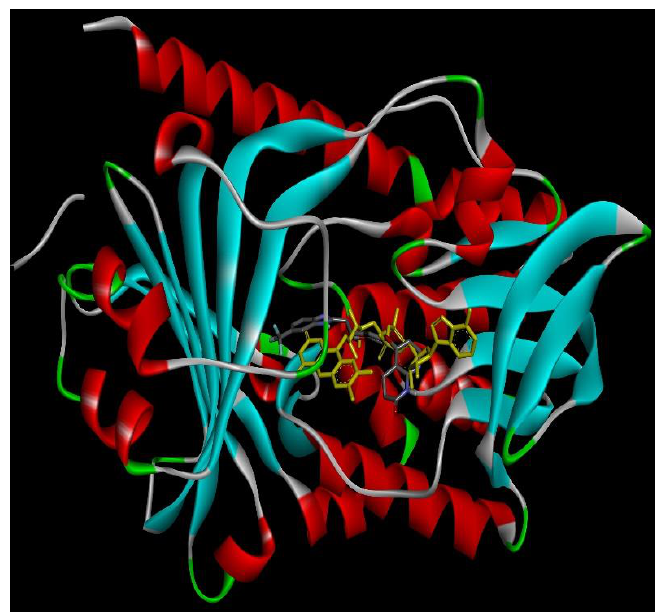
Figure 3. Docking conformation of Lifirafenib (gray stick) and FMN (yellow stick) in phzG.